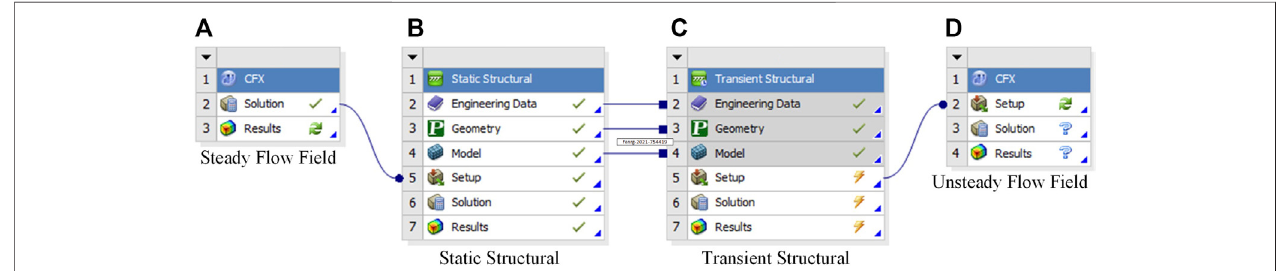
FIGURE 6 | Flow chart of fl uid structure coupling